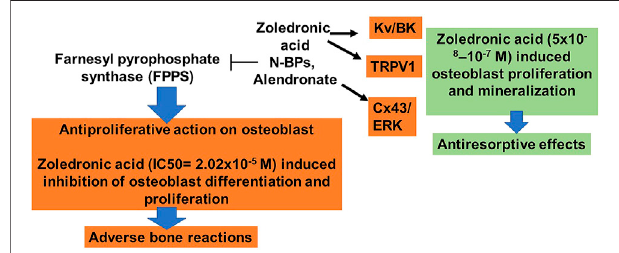
FIGURE 4 | Dual actions of BPs on osteoblasts. Zoledronic acid- induced osteoblasts proliferation in the nanomolar concentration and activating ion channels and antiproliferative action in the micromolar concentrations. Also, nitrogen-containing BPs can inhibit FPP synthase, preventing cholesterol synthesis but at two hundred higher concentrations in respect to the